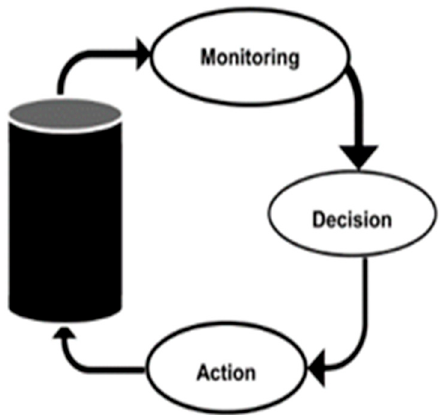
Figure 7. Control system of closed loop in CPS [64].